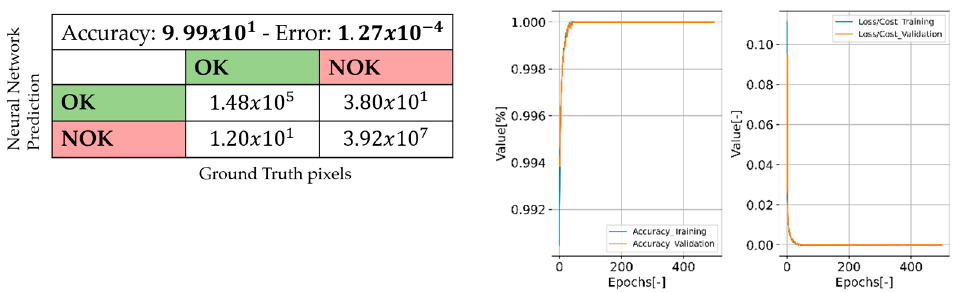
Figure 7. Confusion matrix (validation data), results of the training process.